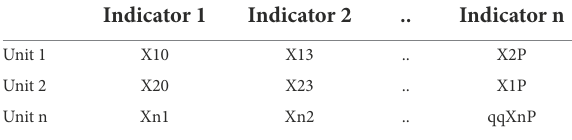
TABLE 1 Cluster analysis sample data table.